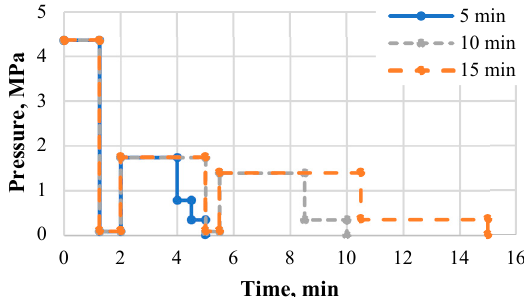
Figure 1. Time–pressure diagram for binder-less board fabrication.